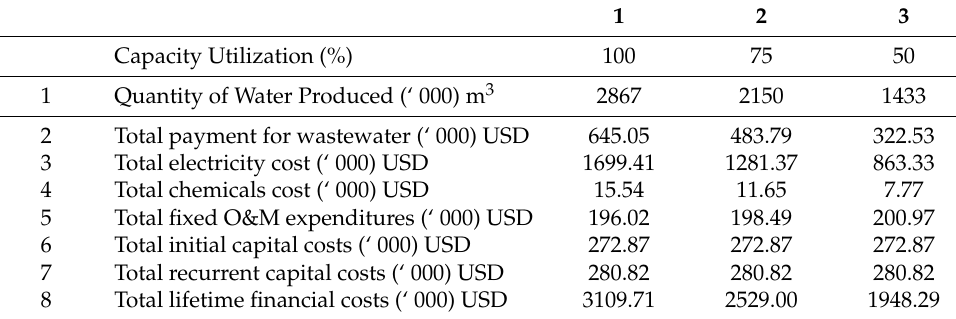
Table 2. Present Value of Output and Costs by Levels of Operation Capacity, 2022 Prices.